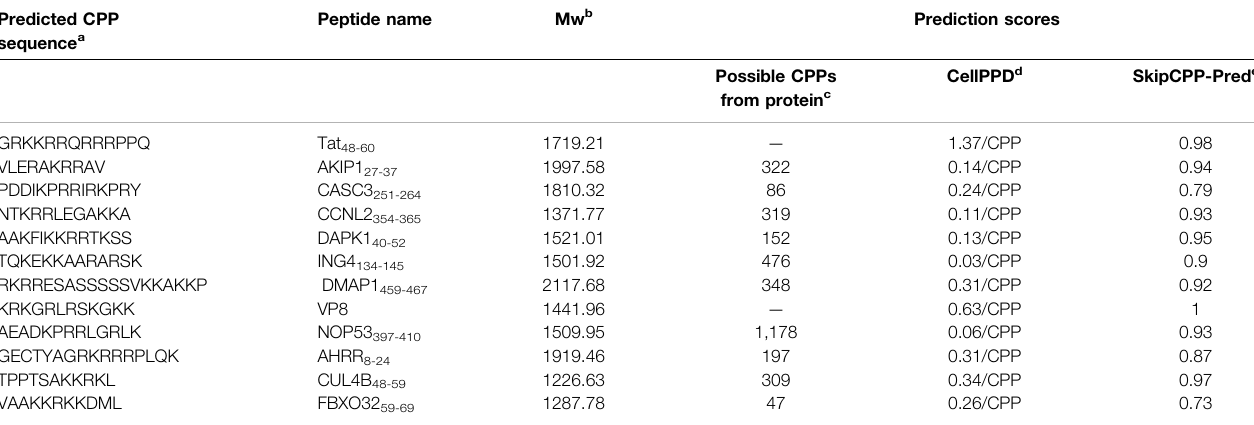
TABLE 2 | Predicted CPP sequence, calculated molecular weight, and prediction scores for